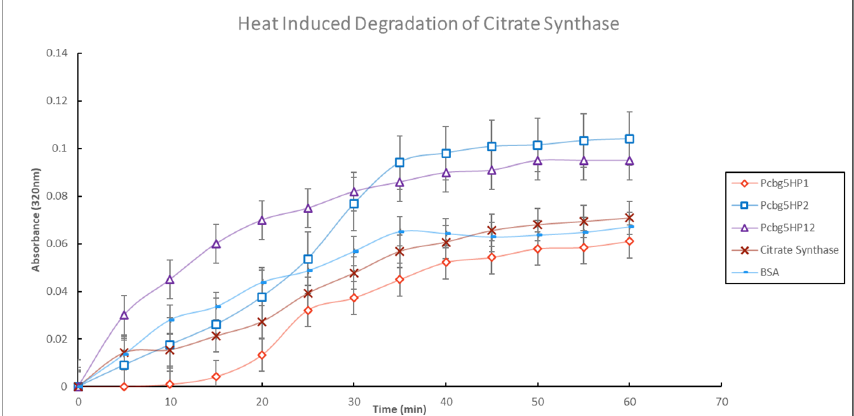
Figure 7. Heat-induced denaturation of citrate synthase. A total of 300 nM recombinant proteins of P. cryoconitis BG5 were purified and incubated at 43 °C with 150 nM citrate synthase, and turbidity was measured at 320 nm. Data were representative of three biological replicates and were expressed as the mean ± SD. BSA at 300 nM was a control sample for citrate synthase non-specific protection.